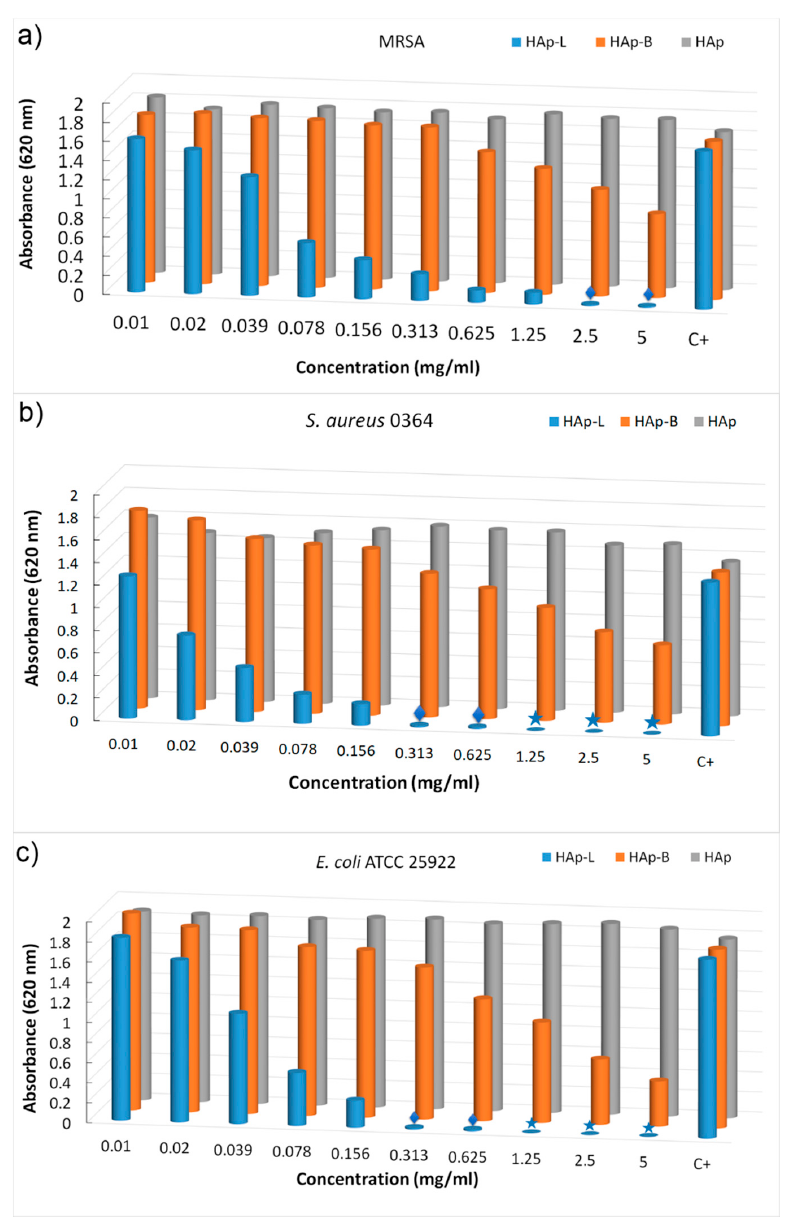
Figure 8. Graphic representation of absorbance values of the microbial culture obtained in the presence of the plant EO-coated HAp (HAp-B and HAp-L) on different bacterial strains such as MRSA ( a ), S. aureus ( b ) and E. coli ( c ), quantified by the A620 nm